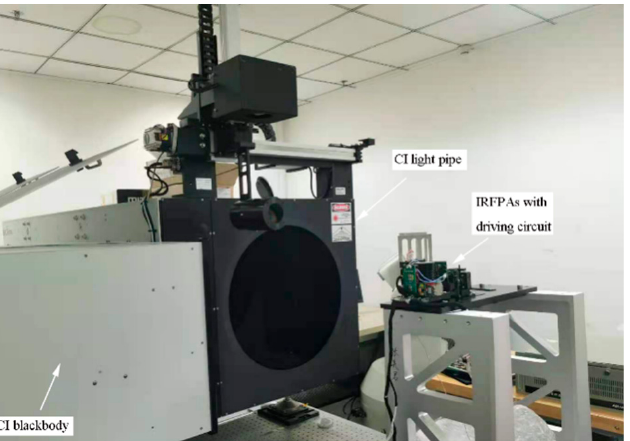
Figure 6. Experiment for TPC: Testing the response slope of the IRFPA And calculating the correc- tion coefficients with and without the atmospheric transmittance filter. Table 1. IRFPA parameters.